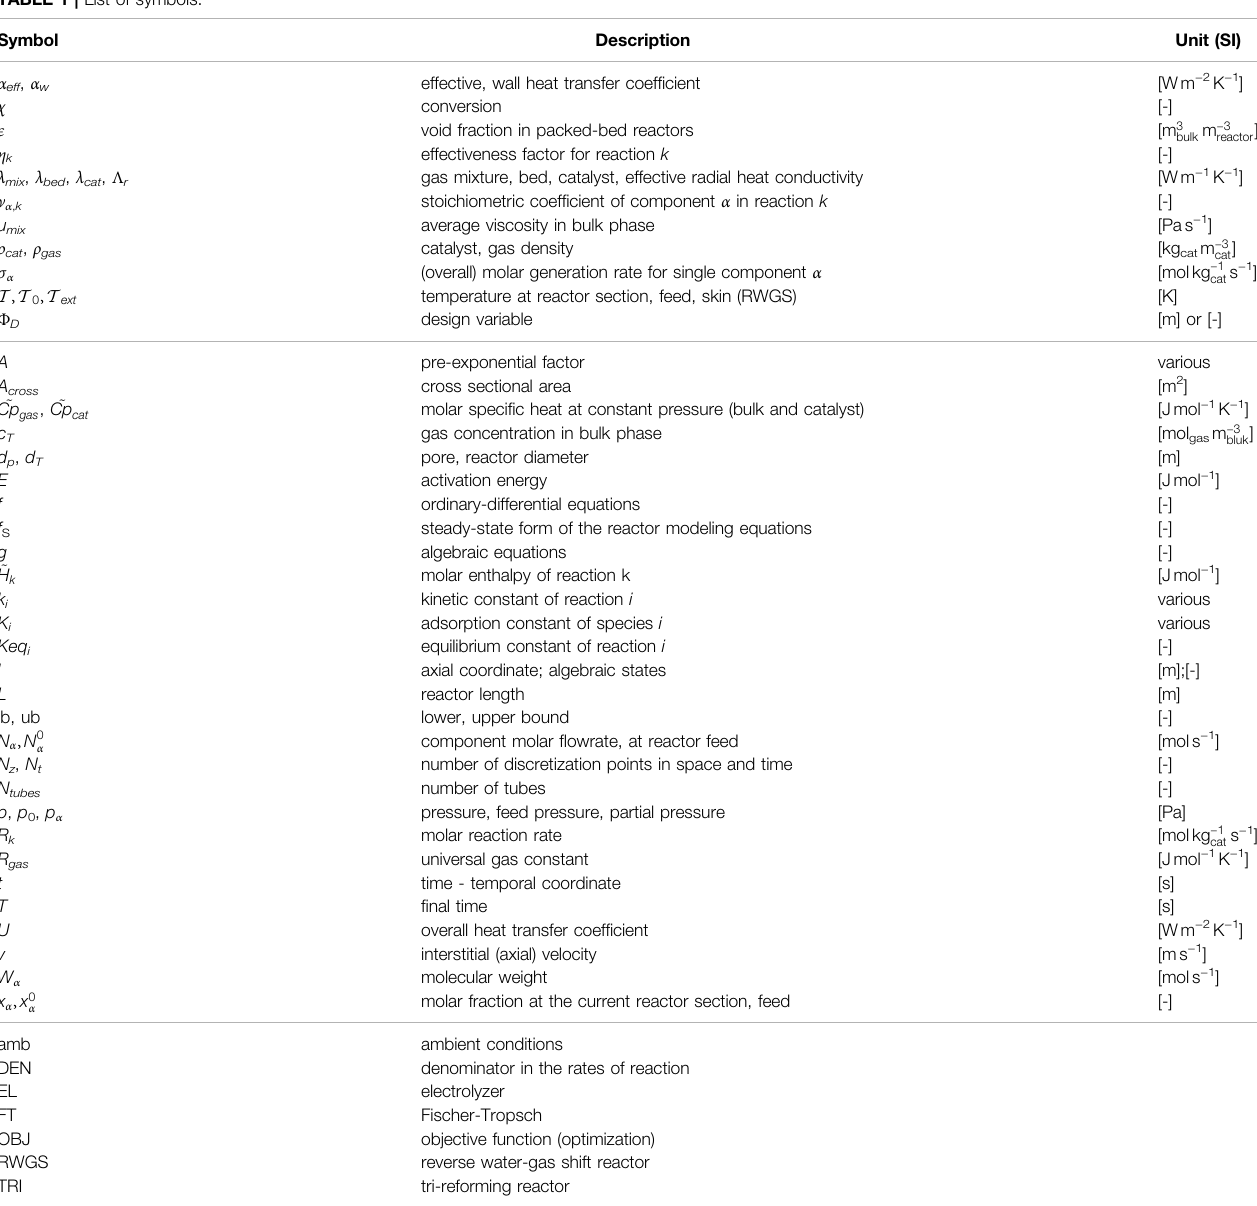
TABLE 1 | List of symbols.